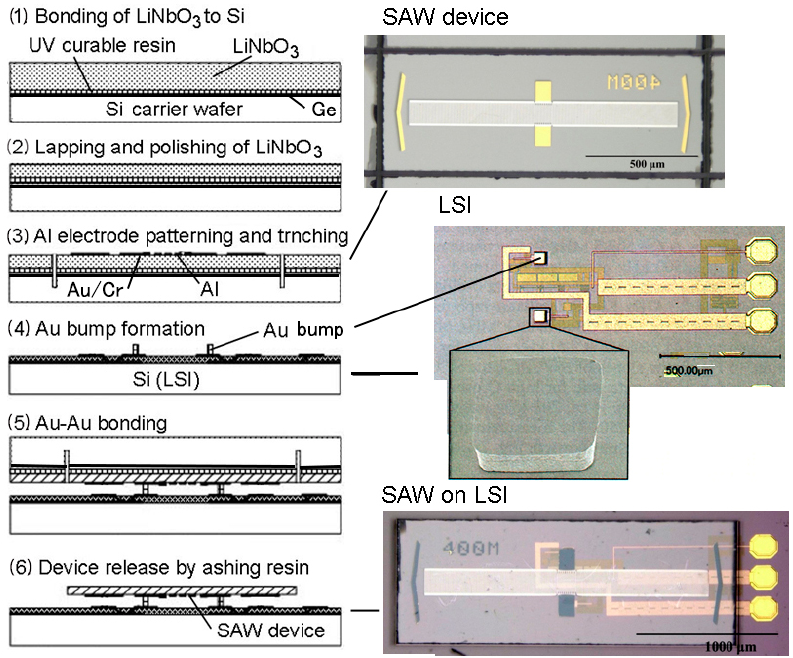
Figure 6. Fabrication process of SAW resonator on LSI.